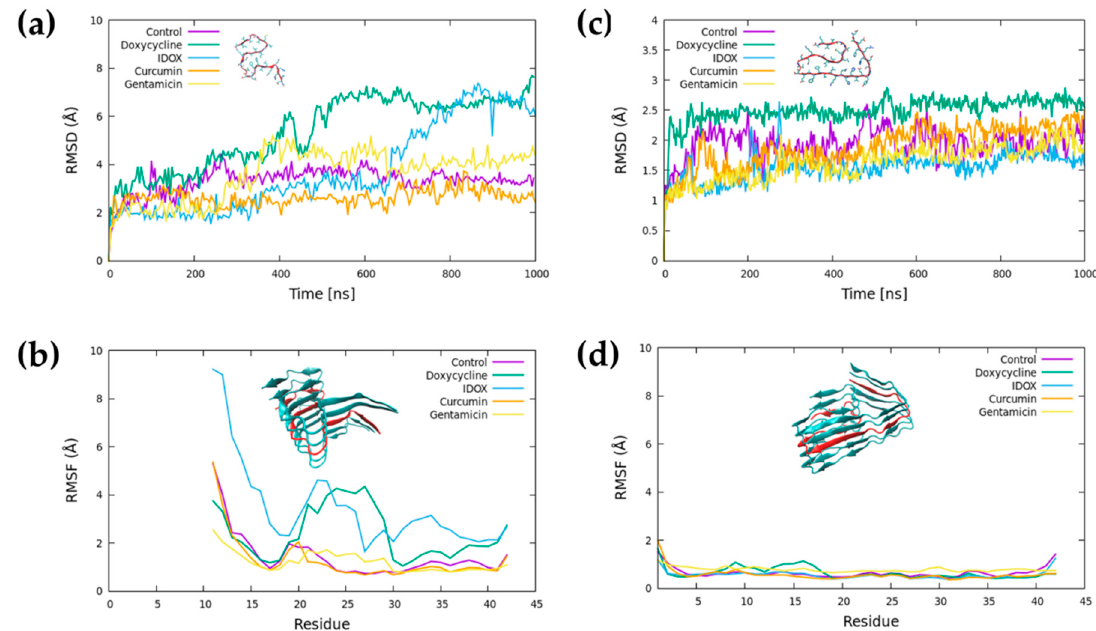
Figure 3. Molecular dynamics (MD) simulations in the absence and presence of the small molecules. Root-mean-square deviation (RMSD) calculated using the C α of each residue (only one trajectory per systems is shown) ( a , c ). The root-mean-square fluctuations (RMSFs) ( b , d ) were measured using the C α of each residue of the central peptide, excluding the first 200 ns of the MD simulations, and were averaged over triplicate simulations.